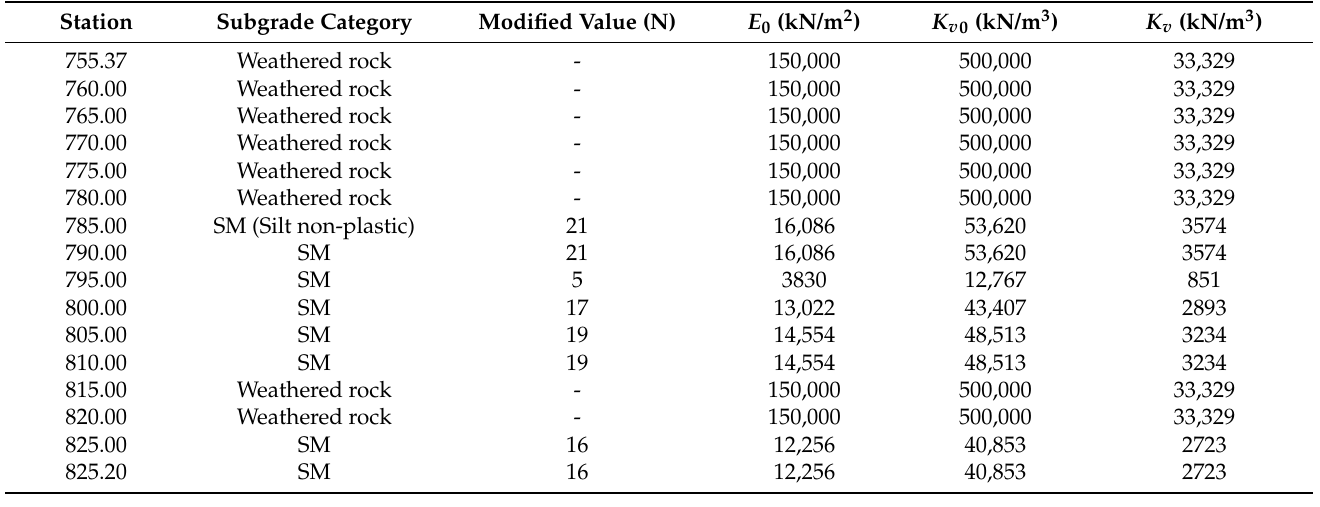
Table 1. Calculation of subgrade reaction.